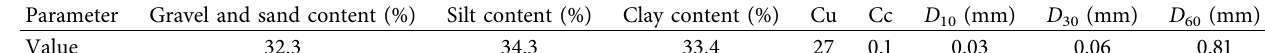
Figure 2: Grading curve of the residual soil. Table 2: Grading parameters of the residual soil.